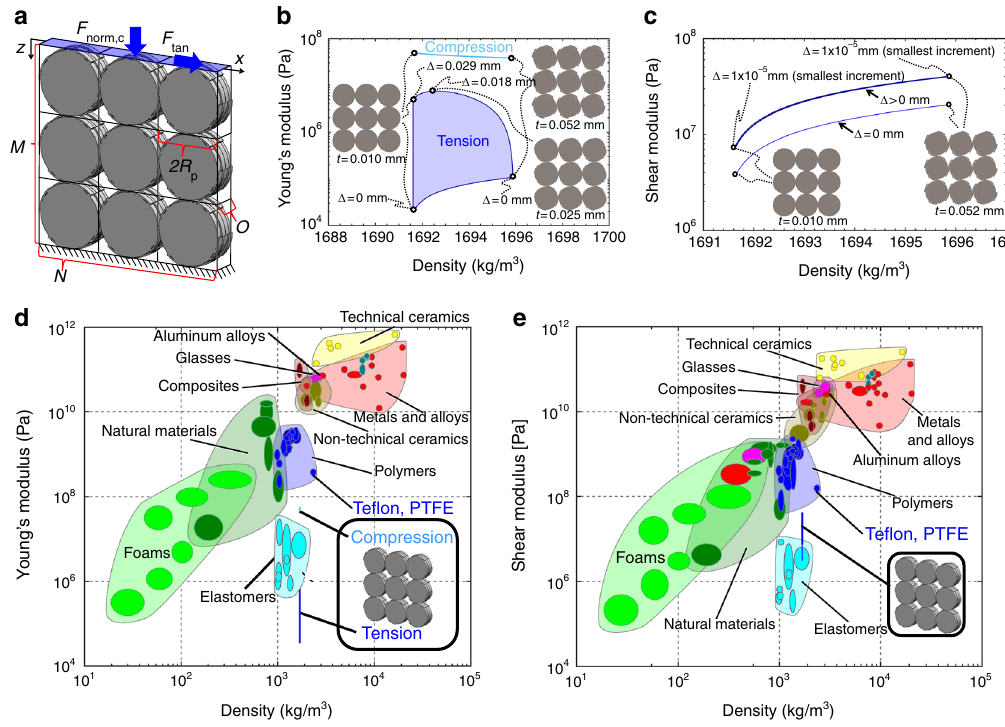
Fig. 7 Properties of square-tessellated compliant rolling-contact architected materials (CRAMs) made of Te fl on. a Parameters that de fi ne the geometry of square-tessellated CRAMs. b Performance regions for the compressive and tensile Young ’ s modulus versus density and c shear modulus versus density achieved by such CRAMs. Extreme CRAM examples are provided from along the boundaries of these regions. d , e The same performance regions plotted on Ashby plots to compare the properties of square-tessellated CRAMs made of Te fl on with other common